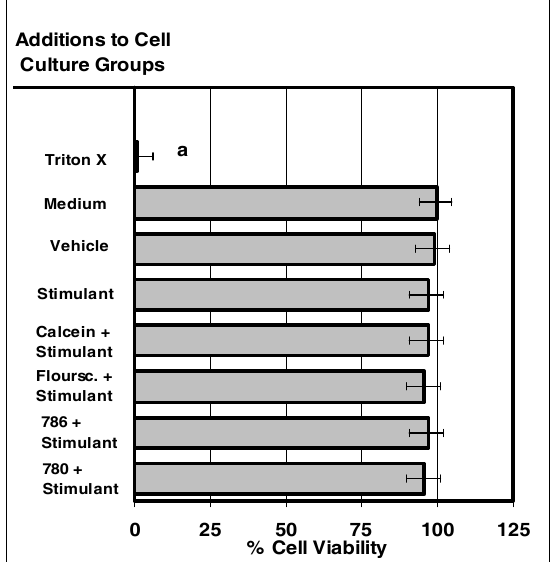
Figure 7: The internalization of VIS or NIR micro-sensor dyes did not alter normal cell viability. Neutrophil cultures were treated with either vehicle, visible micro-sensor dyes (fluorescein or calcein; 20 µg/10 6 cells), or NIR micro- sensor dyes (NIR-786 or NIR-780; 20 µg/10 6 cells) and incubated for 24